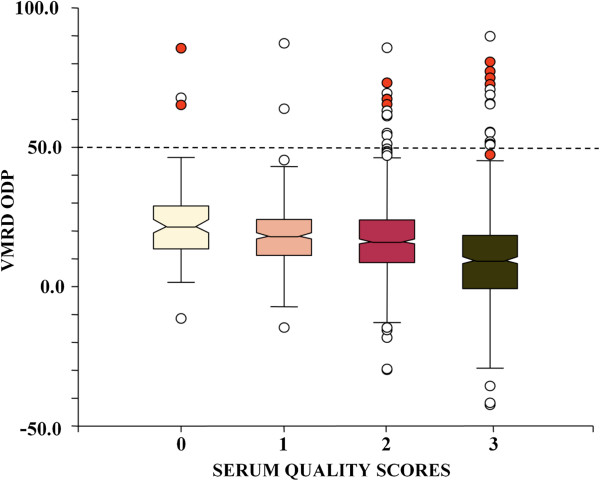
Box plots of the VMRD ELISA results in relation to serum quality. Red dots represent the BTV-8 seropositive animals as confirmed by SNT. Dashed line indicates the 50% cut-off value defining a positive sample as recommended by the manufacturer.